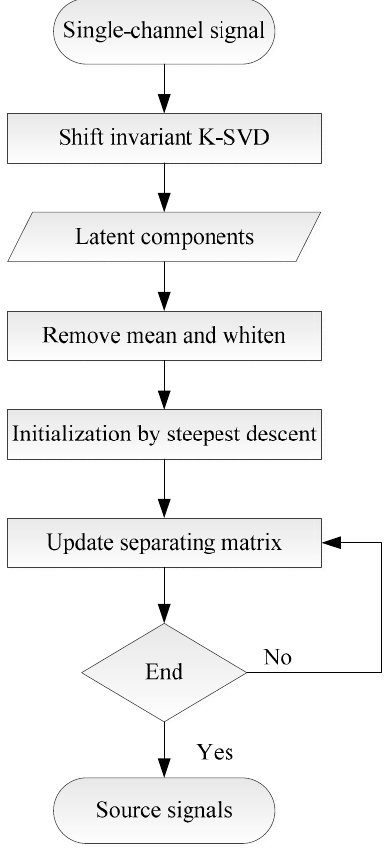
Figure 1. Diagram of the presented method.